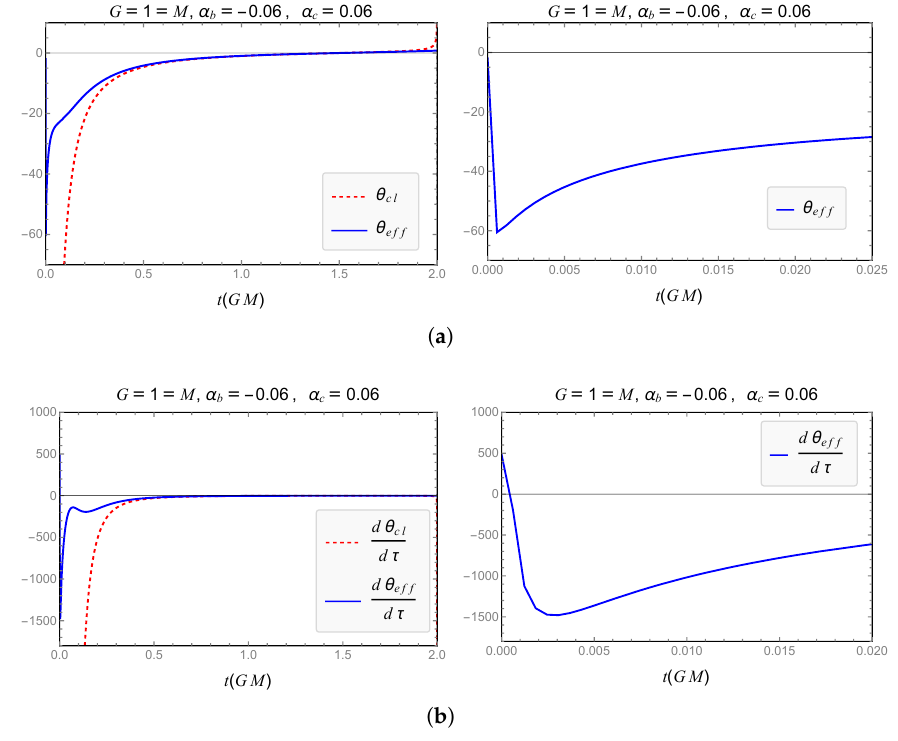
d θ ( TL ) ( TL ) GUP ( 3 ) Figure 19. θ and . Both effective expressions go to finite values as t → 0. ( a ) Left: d τ GUP ( 3 ) Classical vs. timelike θ in GUP model 3 as a function of the Schwarzschild time t . Right: Close up of the left figure close to t = 0. ( b ) Left: Classical vs. timelike d θ Schwarzschild time t . Right: Close up of the left figure close to t = 0.